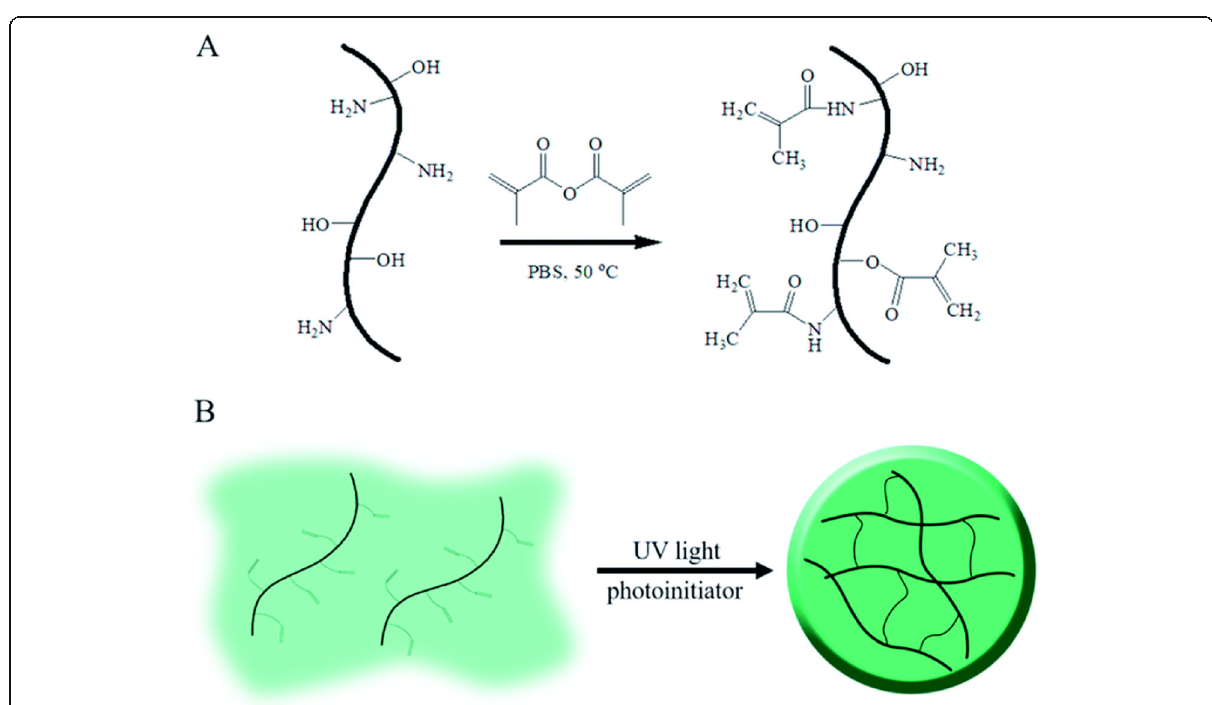
Fig. 1 Diagram of GelMA synthesis and photocrosslinking. Reproduced with permission [16]. Copyright (2019), The Royal Society of